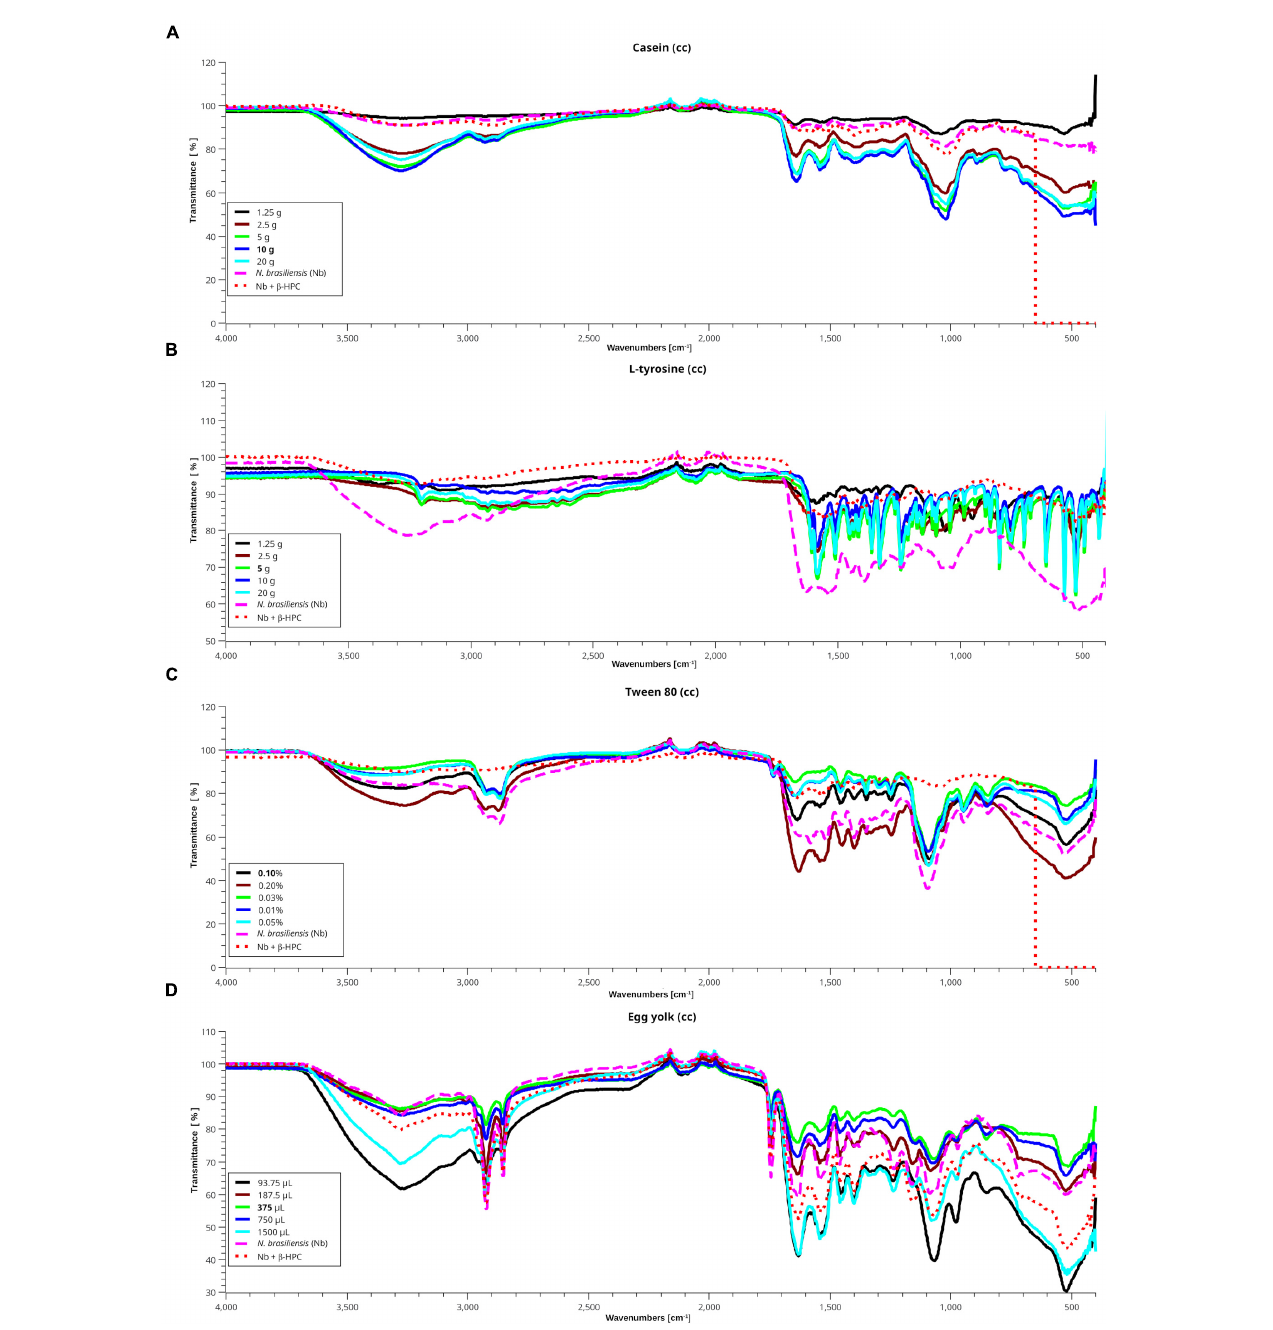
FIGURE6 Interpolation of the hydrolysis of N. brasiliensis on substrates within the calibration curve. In the presence and absence of β -HPC with different standard concentrations from the calibration curves (cc) of each substrate, using the SCiDAVis program. (A) Casein spectra (cc), a transmittance value tending to 100 indicates degradation of this substrate. The spectra of hydrolyzed casein (10 g) with N. brasiliensis alone (dashed fuchsia line) or N. brasiliensis + β -HPC (dotted red line) are similar to that of 1.25 g (black line), proving that hydrolysis took place. (B) The L-tyrosine spectra showed the functional groups previously described between 1500 and 400 cm − 1 ; even when the detected signals are shorter due to dilution. The spectrum of hydrolyzed L-tyrosine by N. brasiliensis (dashed fuchsia line) showed a broader OH signal at 3650 cm − 1 with a transmittance value of 75, and at 1550 cm − 1 , with a transmittance of 60. On the contrary, the spectrum of hydrolyzate by N. brasiliensis + β -HPC is similar to that of 1.25 g (black line) with a transmittance greater than 90, indicating almost complete hydrolysis of the substrate. (C) In the Tween 80 cc, the hydrolyzate by N. brasiliensis corresponds to that of 0.2% concentration of this substrate. However, such results indicated a higher concentration of hydrolyzed compounds, since the concentration for the identification of this substrate is 0.1%; the spectrum hydrolyzed by N. brasiliensis + β -HPC (red dotted line) resembles that of 0.025% (green line). (D) Signals in egg yolk cc spectra show higher amplitude when this substrate is diluted, and in the 3000–3500 cm − 1 range, the hydrolyzed product by N, brasiliensis resembles that of 375 µ L (green line) with a transmittance value of 86. The hydrolyzed lipid of N. brasiliensis + β -HPC correlates to that of 750 µ L (deep blue line) with a transmittance value of 82. N. brasiliensis + β -HPC were closest to the highest concentrations. In the protein window (1800–1500 cm − 1 ) , the substrate hydrolyzed by N. brasiliensis has a transmittance value of 60, and that hydrolyzed by N. brasiliensis + β -HPC presented a transmittance value of 54; such differences were similar throughout the mix and polysaccharide windows. However, broad signals were observed at 93, 75, and 1500 µ L with transmittance values of 30 and 38 in the fingerprint area. In the presence of β -HPC, a signal with a transmittance value signal of 44 was